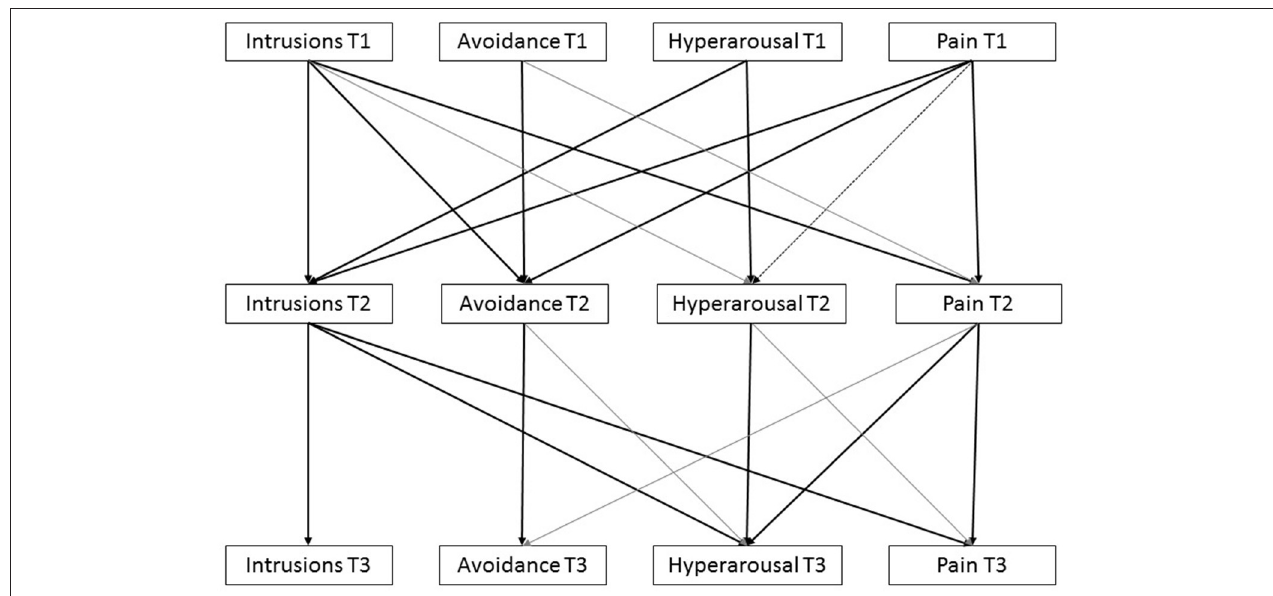
FIGURE 2 | Constrained model presenting estimated pathways connecting pain and PTSD-symptom clusters. Note that black lines are statistically significant associations, gray lines are not statistically significant.